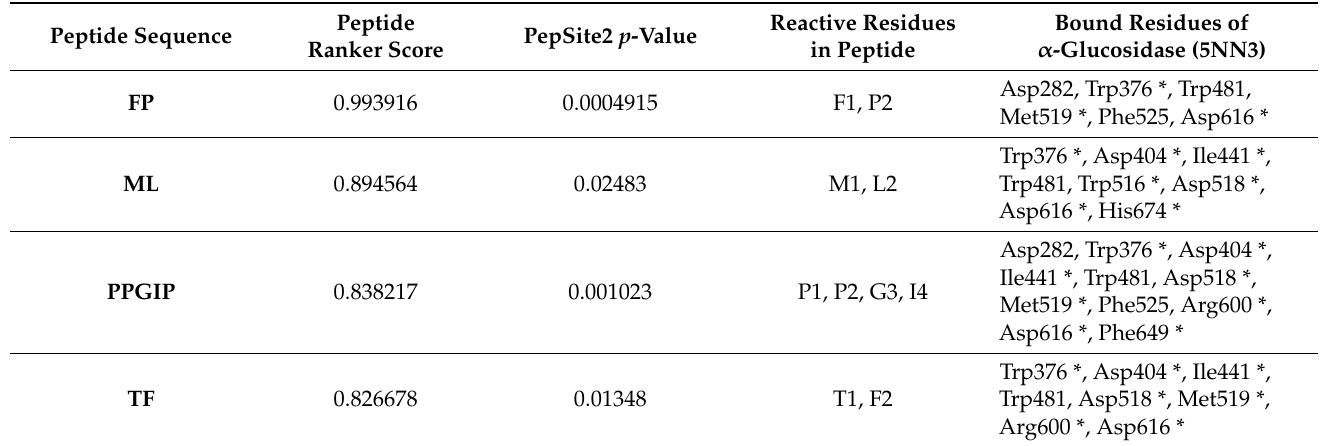
Table 3. Biologically active peptides from a selected lupin protein hydrolysate (FCT) and their binding potential with α -glucosidase (5NN3) as a protein